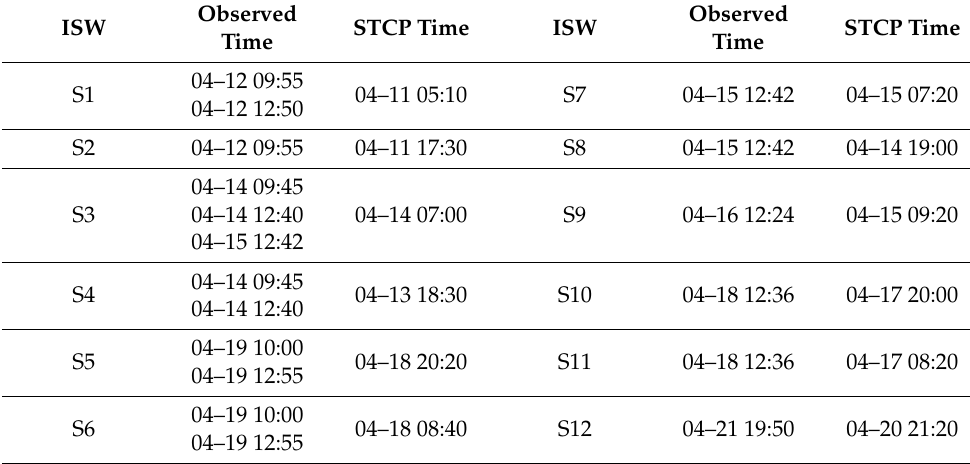
Figure 6. ( a ) Remote sensing images of S3 in the LS taken at 9:45 on 14 April local time. ( b , c ) Barotropic tide variation at the Nusa Penida sill from TPXO. The colored triangles represent the time when the ISWs were observed, and the dotted lines of the same color indicate the tidal current peaks associated with the generation of those ISWs. Table 1. The observed time of ISWs in satellite images from 12 to 21 April 2021 and the occurrence time of southward tidal current peaks (STCP) associated with their